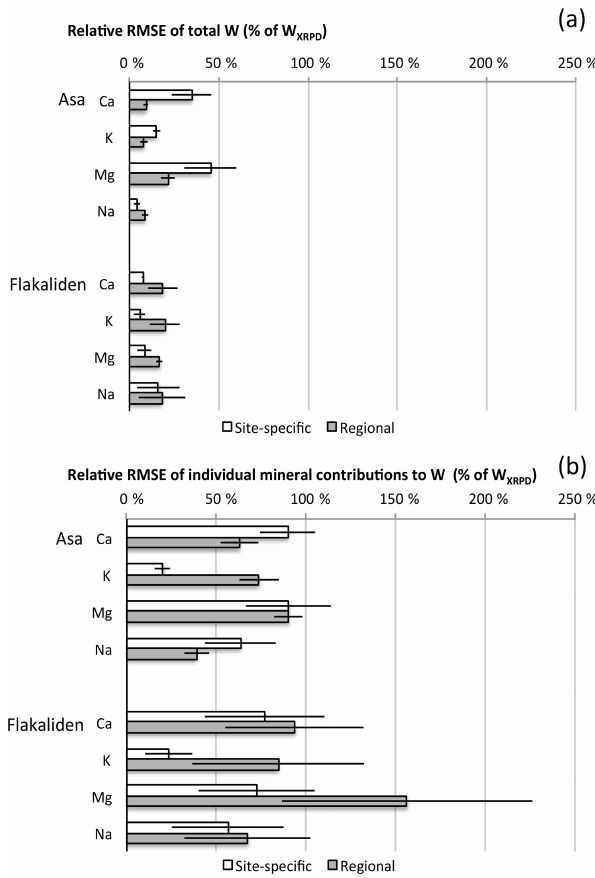
Figure 3. Root-mean square error (RMSE) of average PROFILE weathering rates (mmol c m − 2 yr − 1 ) of 1000 A2M mineralogies per soil layer, compared to weathering rates based on XRPD mineral- ogy per soil layer. Comparisons are based on the total weathering per element (a) and on the sum of mineral contributions to total weathering per element (b) . RMSE describes the prediction accu- racy for a single soil layer.